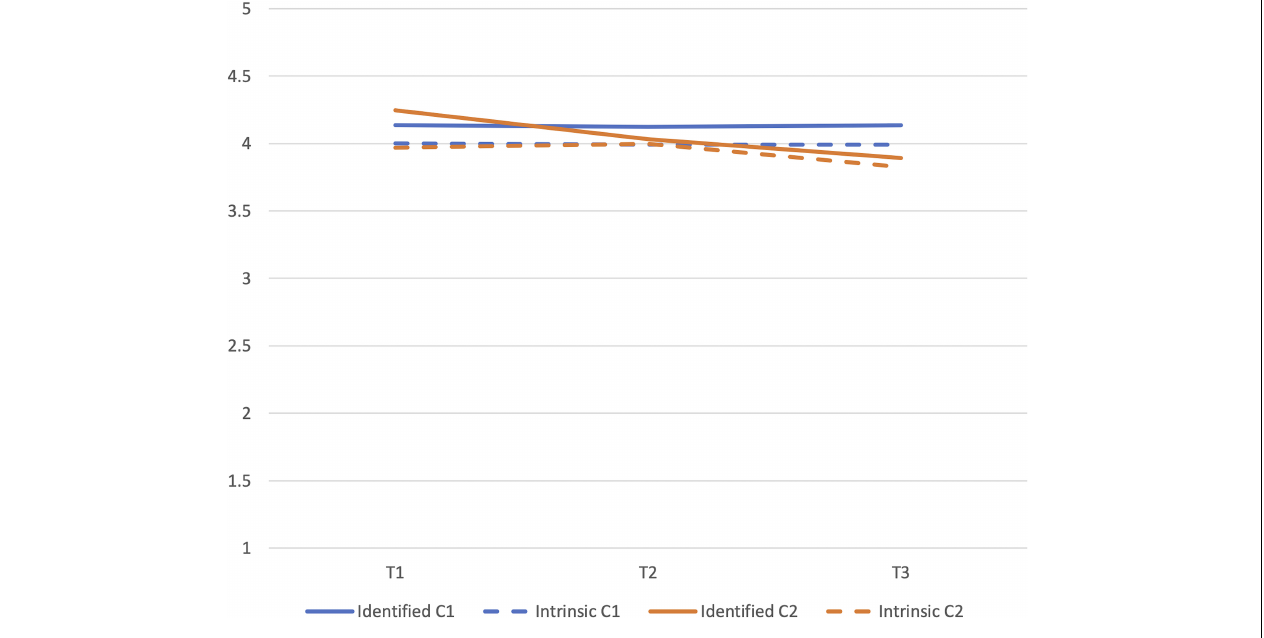
FIGURE 2 | Trajectories of identified and intrinsic motivation by cohort. T3 was collected pre-pandemic (December 2019) for Cohort 1 (C1), but nearly 1 year into the pandemic (December 2019) for Cohort 2